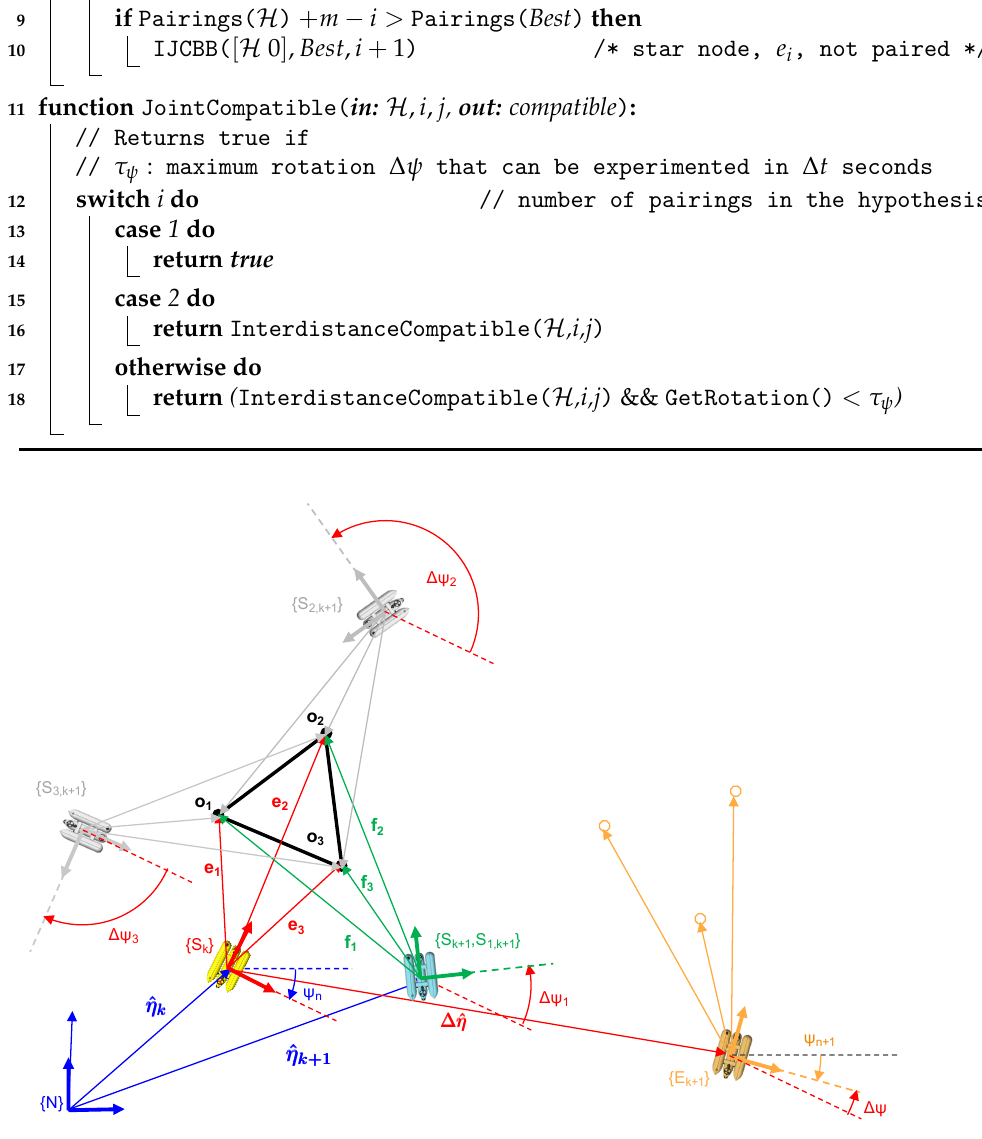
Figure 8. Roto translation